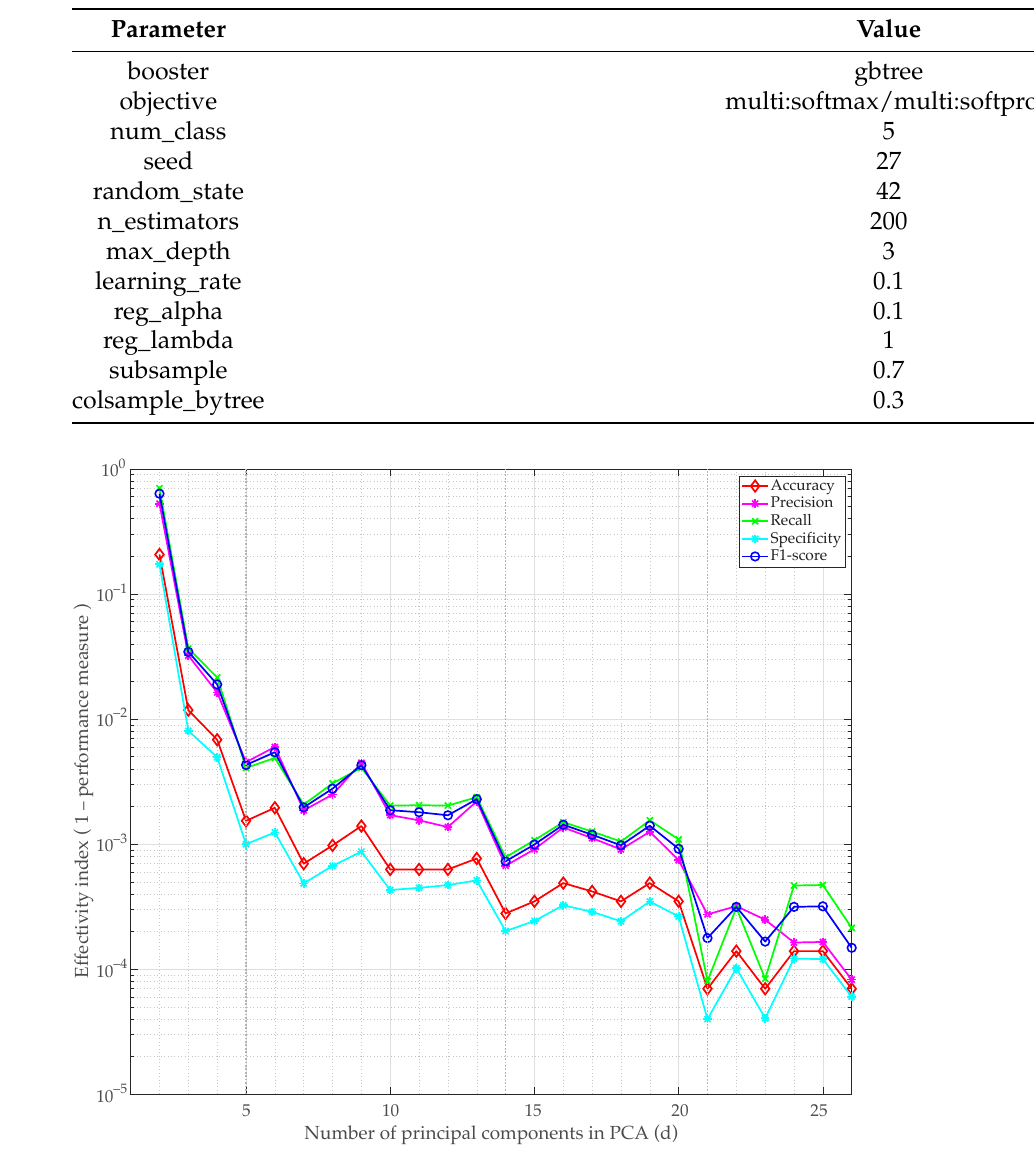
Figure 14. Averaged performance metrics versus the number of retained principal components in the PCA model (semi-logarithmic plot in the vertical axis). The vertical axis represents the effectivity index, i.e., one minus the performance measure.